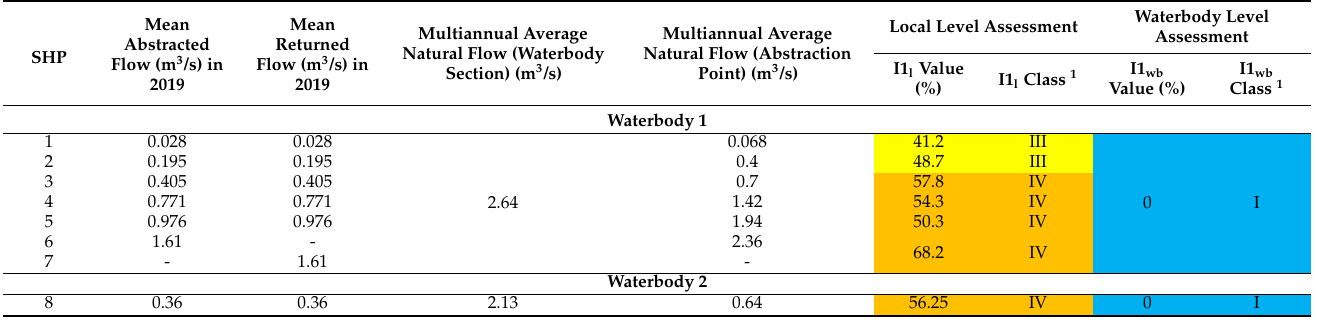
Table 5. The results of the indicator average consumed flow (local and waterbody level).